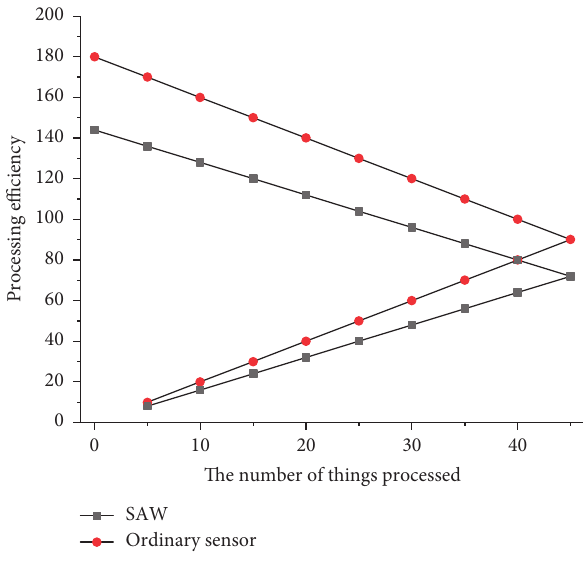
Figure 5: Efficiency of passive wireless